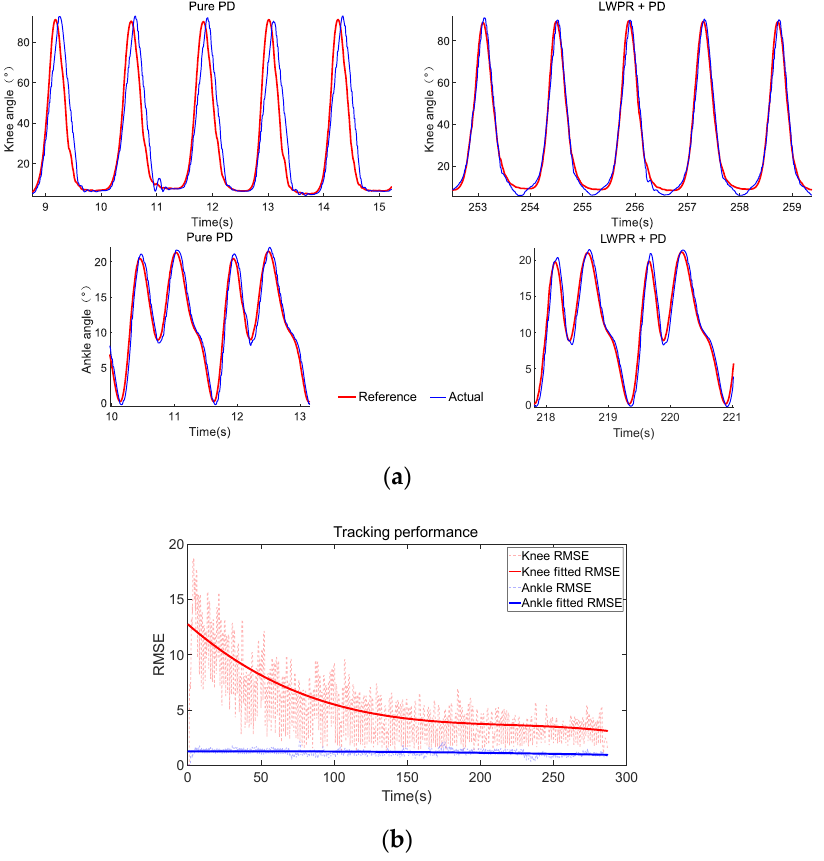
Figure 7. ( a ) Knee and ankle position tracking under different modes. ( b ) Tracking performance of knee and ankle.